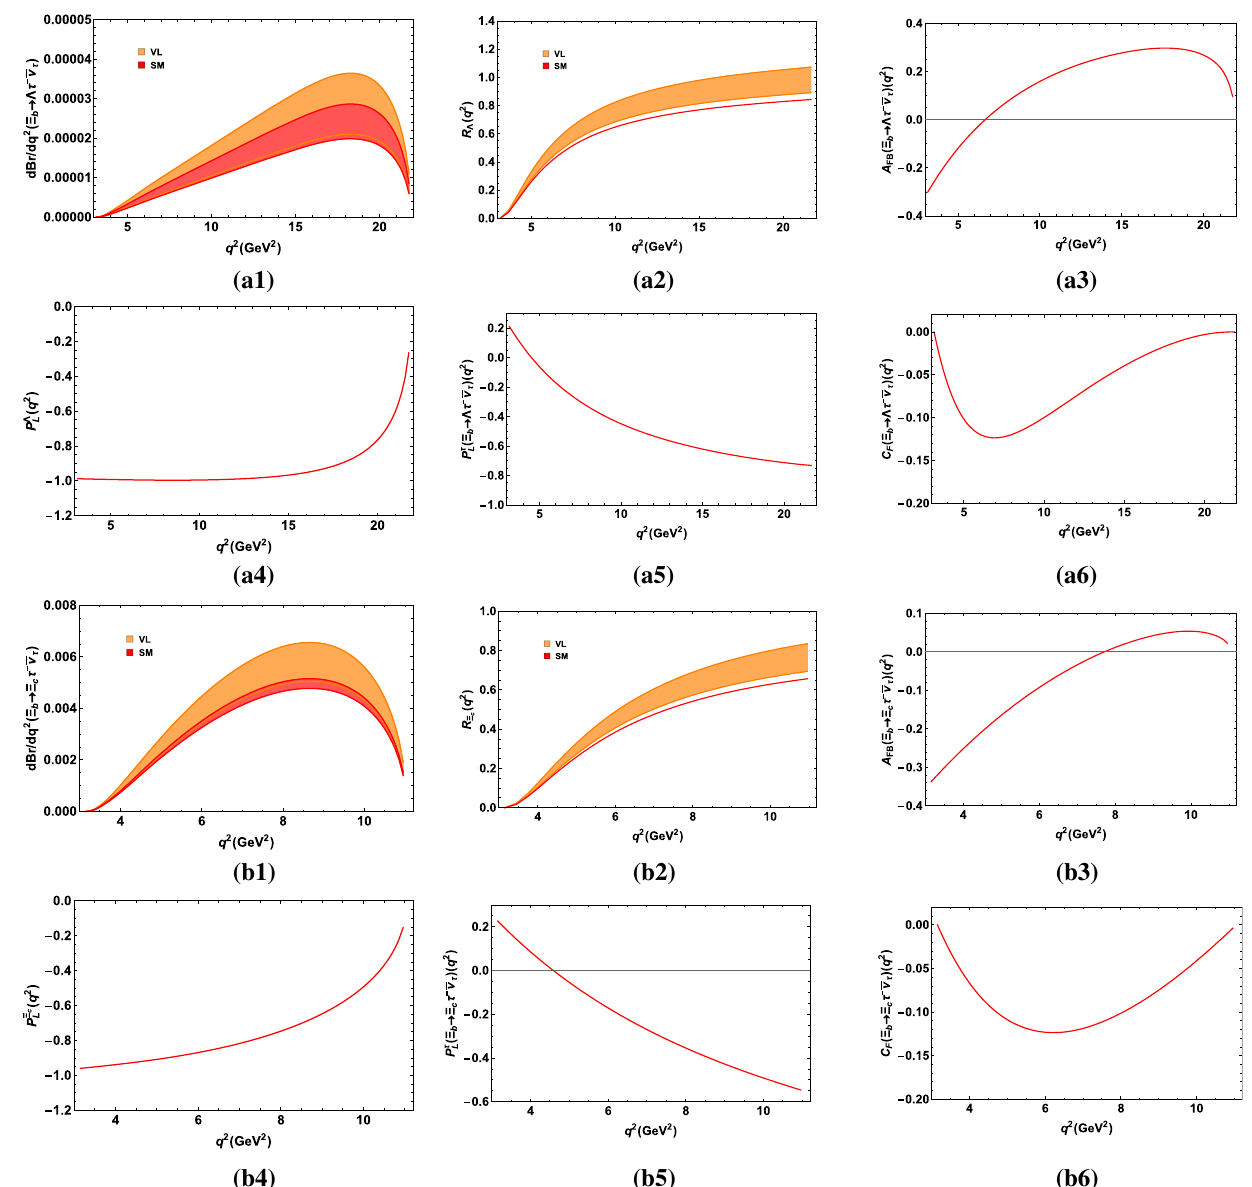
Fig. 3 The SM (red) and NP (orange) predictions in the presence of only V L coupling for the q 2 dependent observables d Br / d q 2 ( a1 , b1